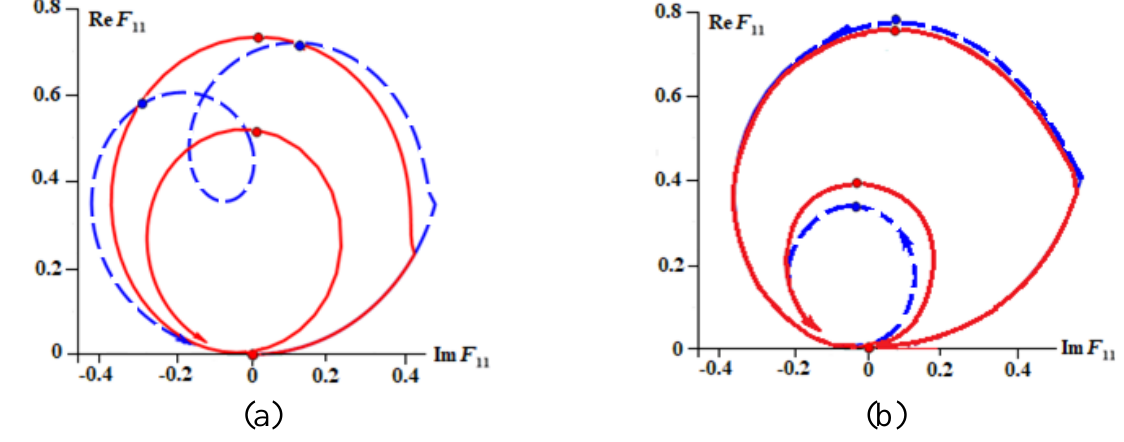
Figure 5. Argand diagrams for the amplitude F 11 in Figure 2 ( a ), and in Figure 4 ( b ). Red solid lines-BW formula (44), blue dashed lines - K -matrix Equation (46).